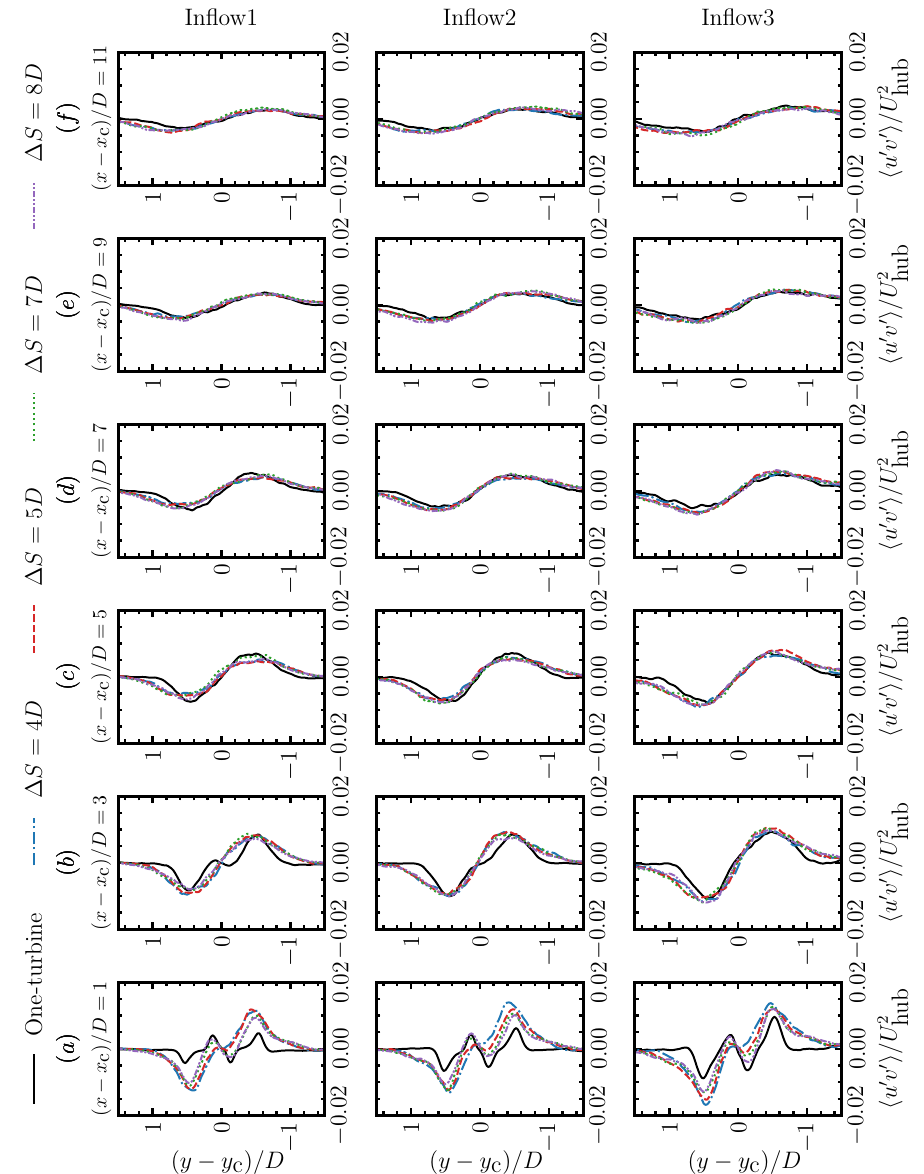
u (cid:48) v (cid:48) downwind of the second turbine of the (cid:104) (cid:105) x c ) / D = 1, ( b ) 3, ( c ) 5, ( d ) 7, −